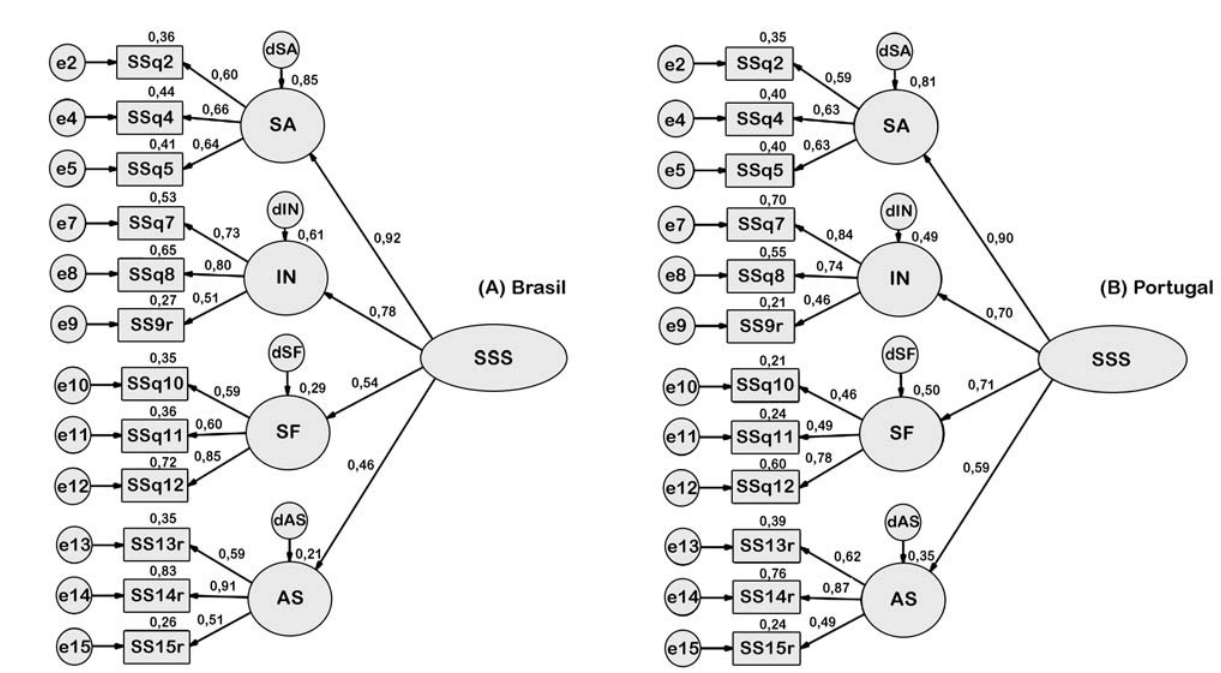
Figura 2 . Modelo de 2ª ordem da Satisfação com o Suporte Social (ESSS) no Brasil (A) e em Portugal